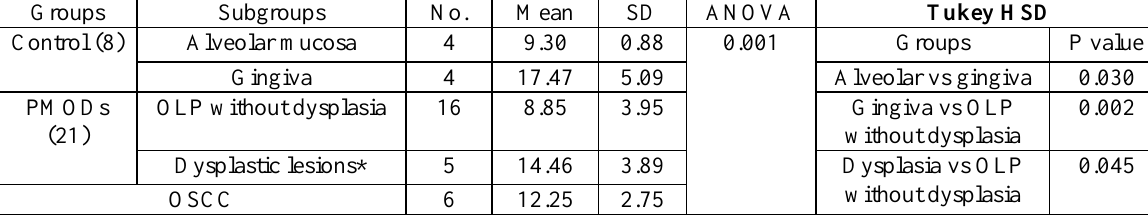
Table (4): The relationship of the MVD to the histopathologic findings in all groups. Groups